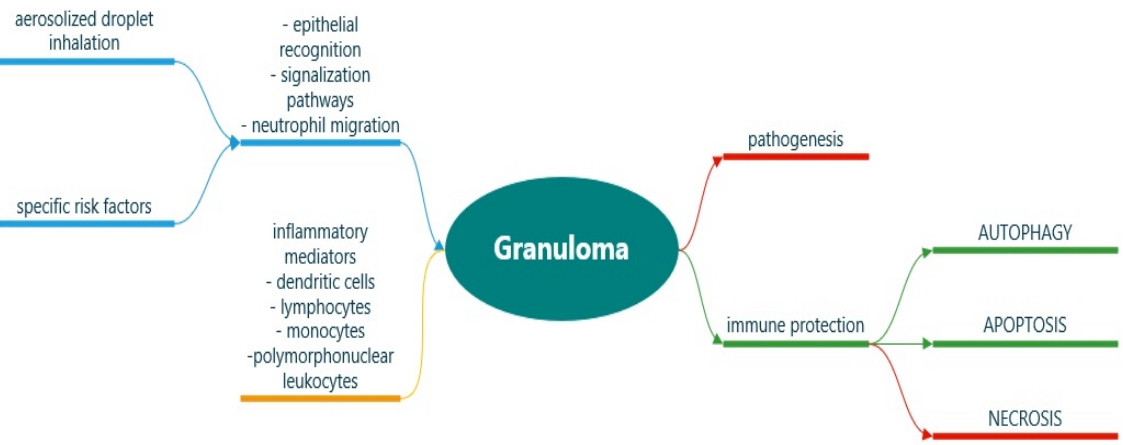
Figure 2. Immunologic pathways in M. tuberculosis infection. Color legend: blue and green represent the host innate and adaptive immune responses involved in mycobacterial recognition and removal; red represents mycobacterial survival and long-term tissue inflammation; and orange represents both pathways that can appear during M. tuberculosis infection: bacillar death or survival.